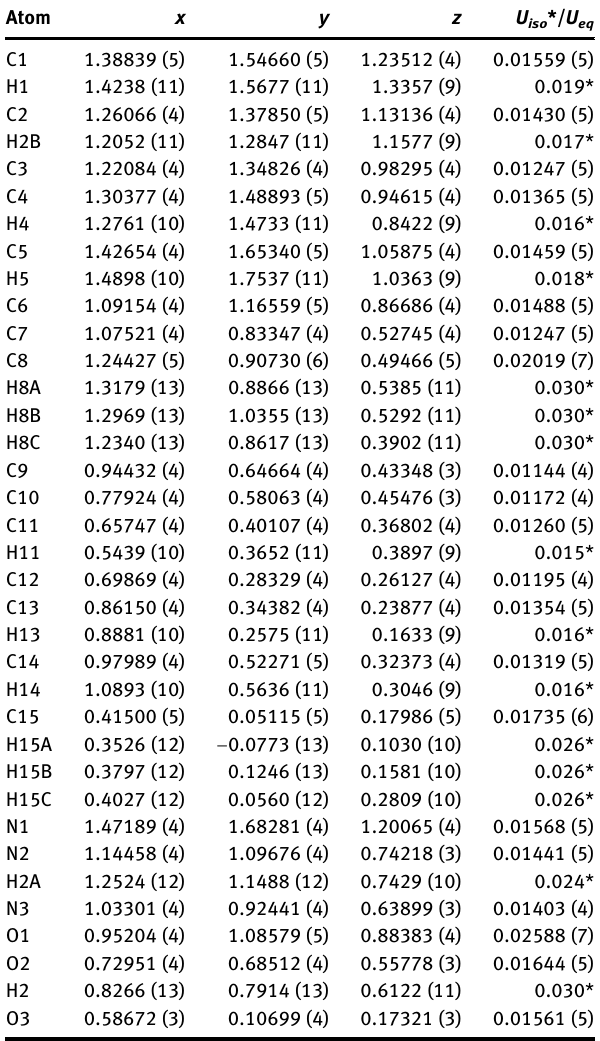
Table  : Fractional atomic coordinates and isotropic or equivalent isotropic displacement parameters (Å 